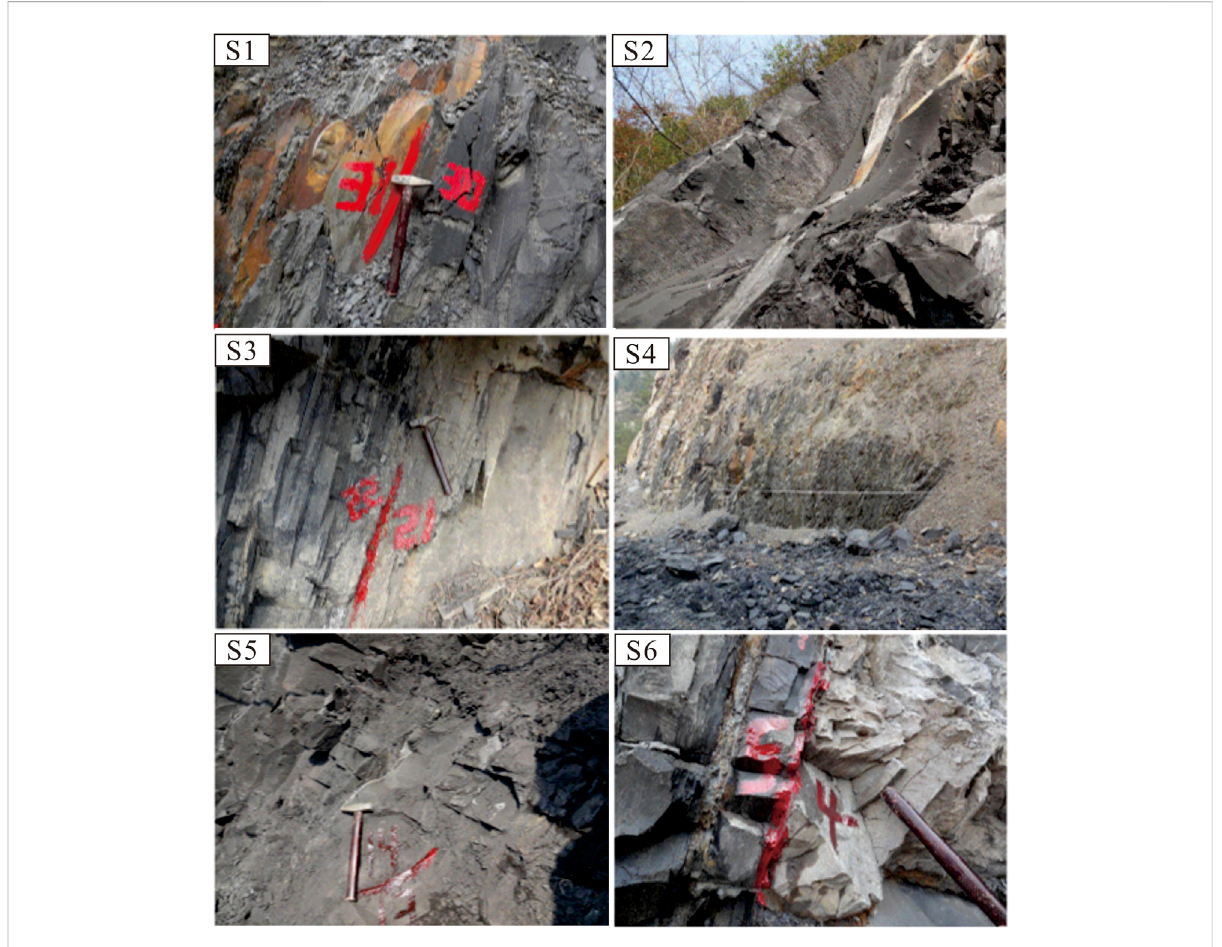
FIGURE 1 Field sampling photograph of the Longmaxi